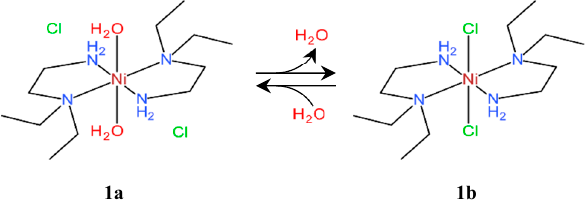
Figure 6. Structural changes of 1a and 1b .